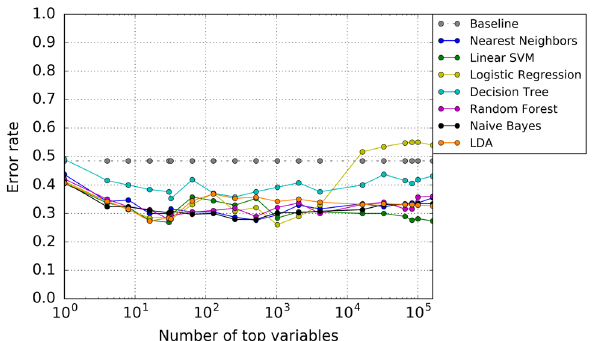
Fig. 3 Classi fi cation of patients vs. controls based on ss-link-weight features. Y-axis shows the average CV error over 95 leave-subject-out folds (see the Supplementary Fig. S4 for the corresponding FP and FN rates) for different classi fi ers, and for varying size of top-ranking feature subset shown on x